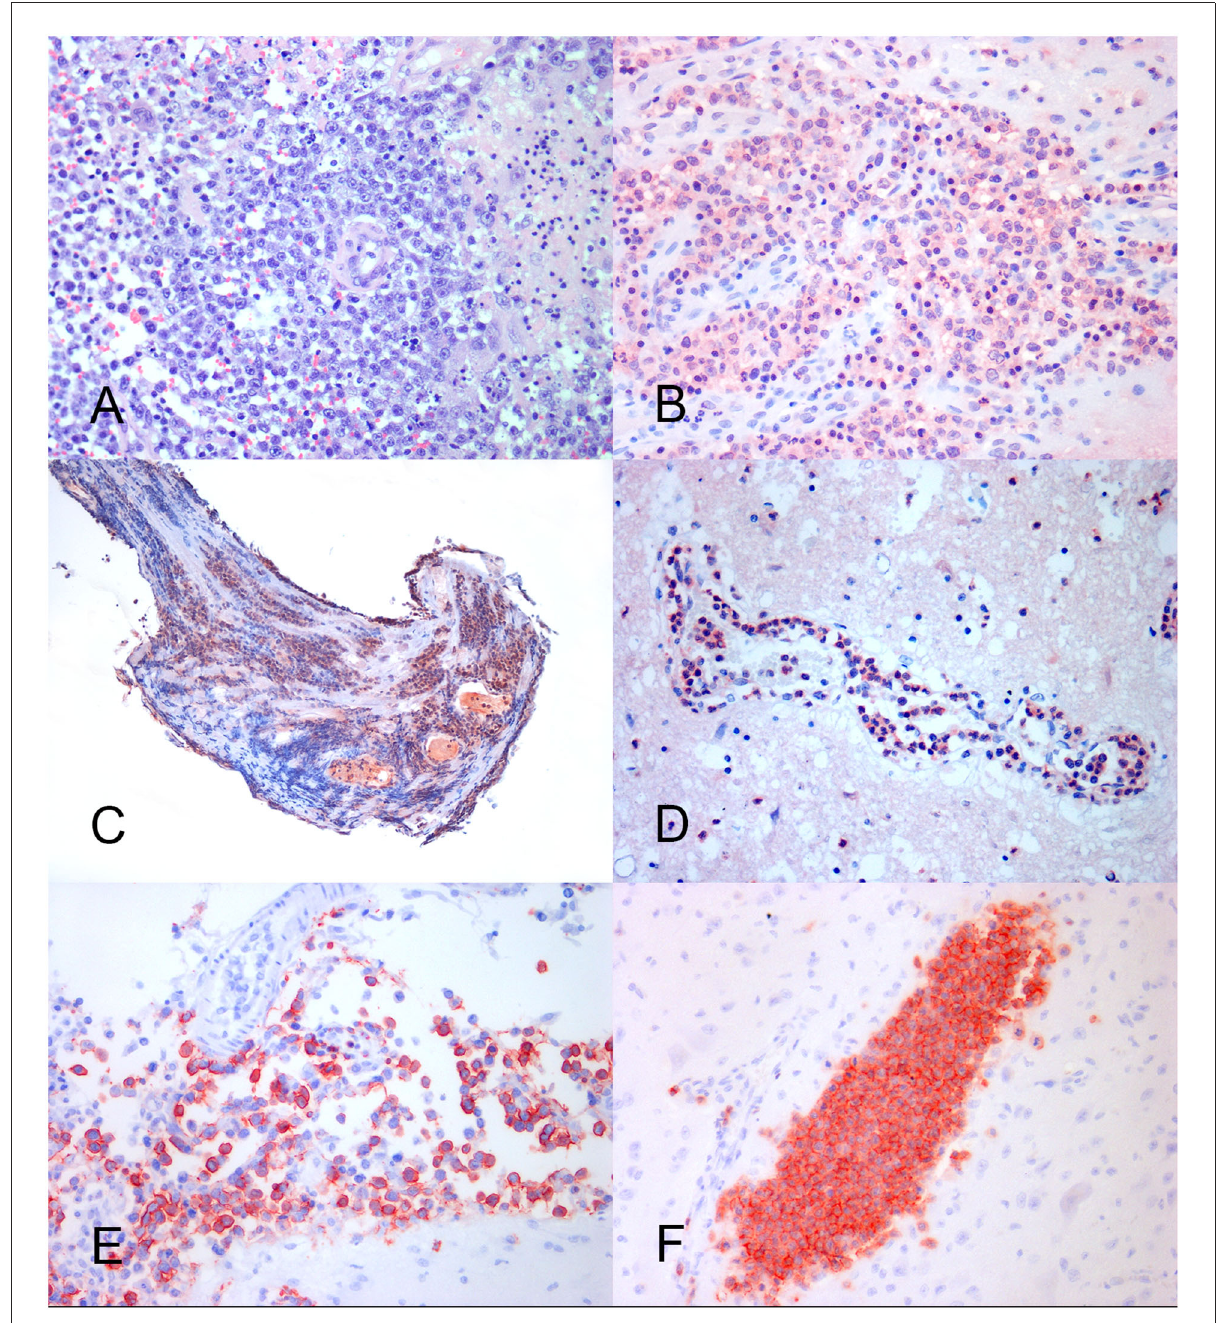
FIGURE2 Feline lymphoma of the nervous system. (A) Neoplastic large lymphocytes with the round nucleus and prominent nucleolus, arranged in a perivascular pattern. HE, × 40. (B) B cell brain lymphoma showing an area of consistent MUM-1 positive nuclear and cytoplasmic immunoreaction. IHC, × 40. (C) Spinal nerve root. Lymphoplasmacytic lymphoma with a prevalence of MUM-1 positive neoplastic cells. IHC, × 20. (D) Brain angiotropic lymphoma showing marked MUM-1 positive cell reaction into the blood vessel lumen. IHC, × 40. (E) B cell brain leptomeningeal lymphomatosis. The subarachnoid space is crowed with CD20-positive neoplastic lymphocytes. IHC, × 40. (F) Brain angiotropic T cell lymphoma. A parenchymal blood vessel is filled with CD3-positive neoplastic cells. IHC ×